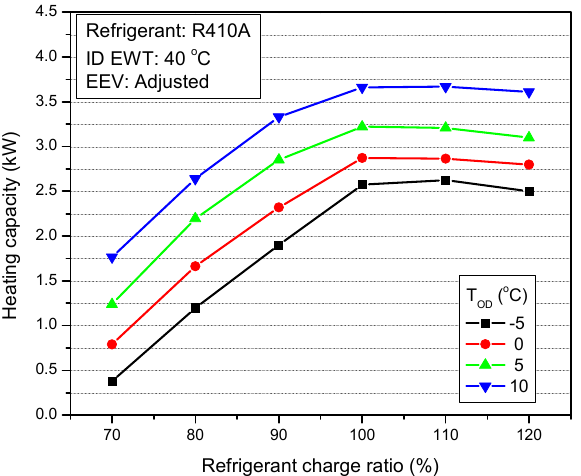
Figure 13. Variation of heating capacity with refrigerant charge ratio and T OD .